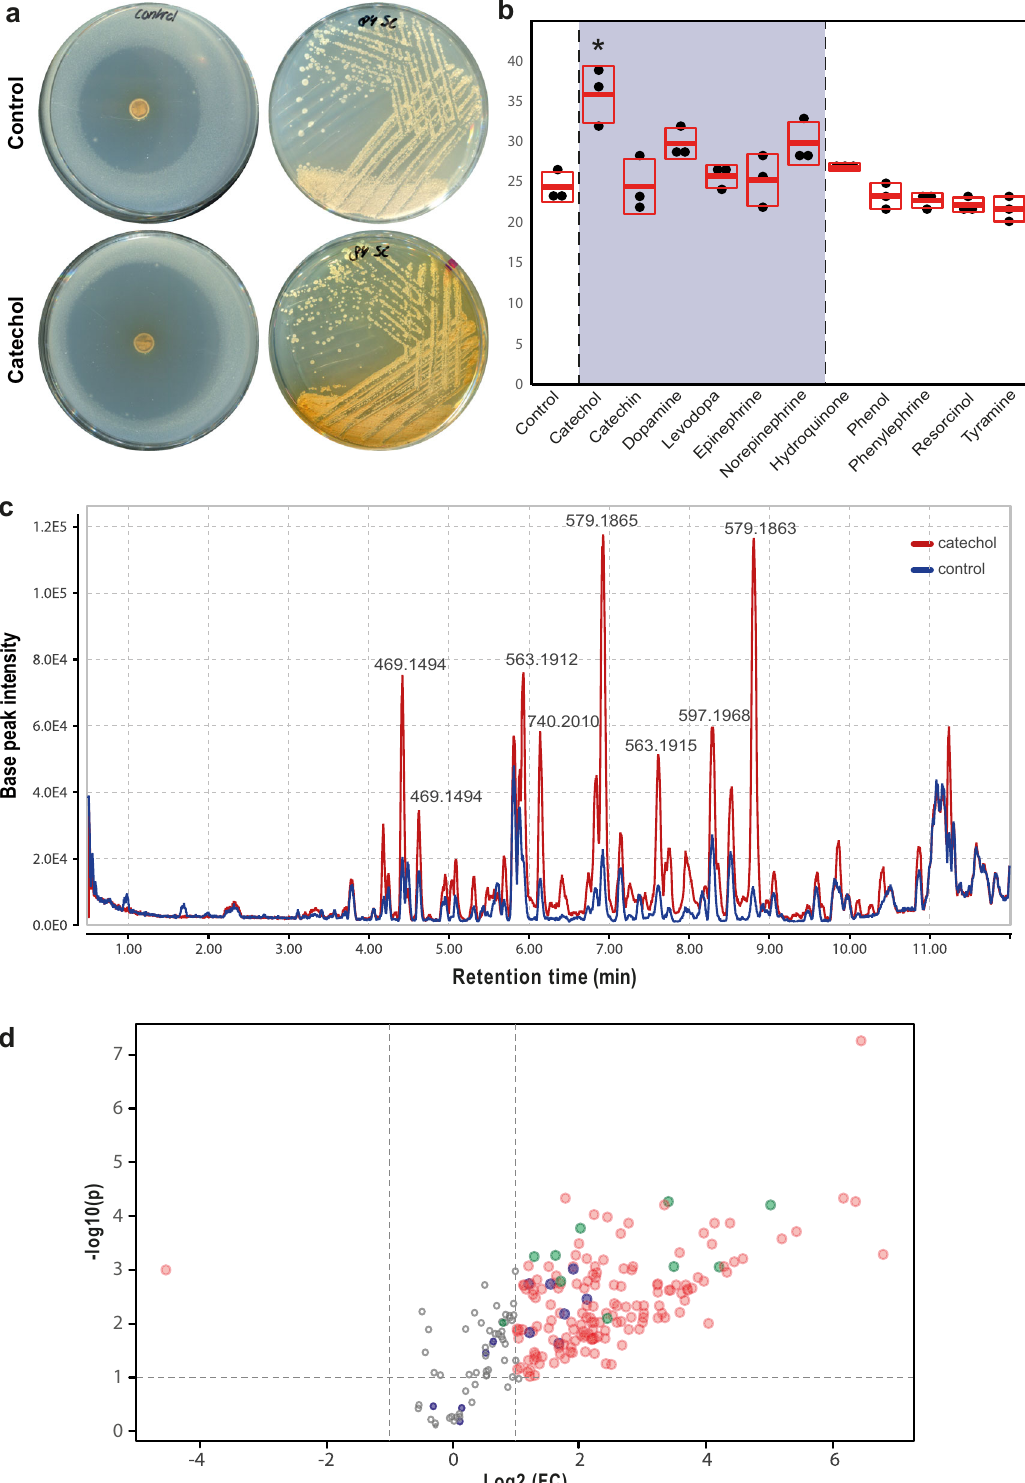
(Table S4) of which BGC4 shows high similarity to the saquaya- sp. MBT84 . To identify the gene cluster responsible for the mycin A BGC, and was therefore most likely responsible for the production of the angucycline glycosides (Fig. 5a, Table